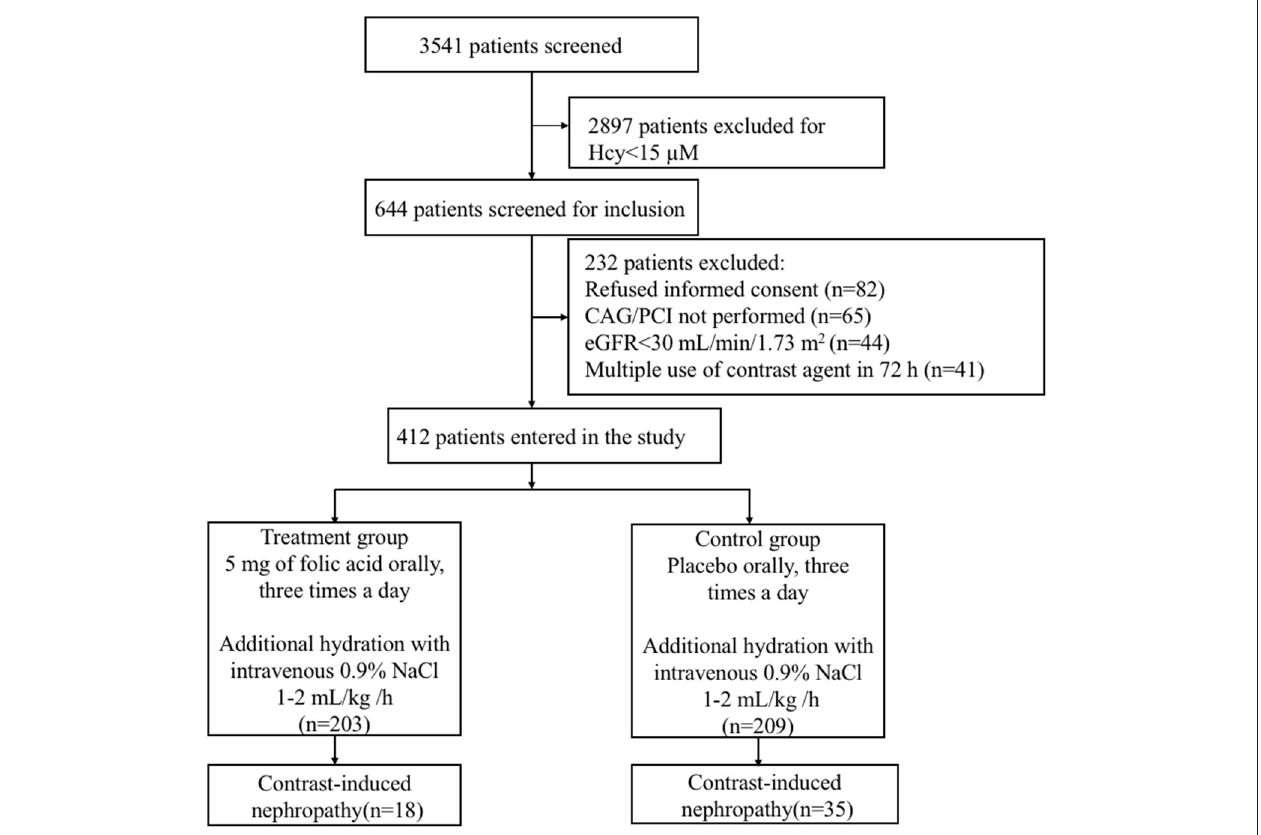
FIGURE 1 | Flowchart of the study population of patients with hyperhomocysteinemia receiving folic acid and the control group. CAG, coronary arteriography; PCI, percutaneous coronary intervention; eGFR, estimated glomerular filtration rate.